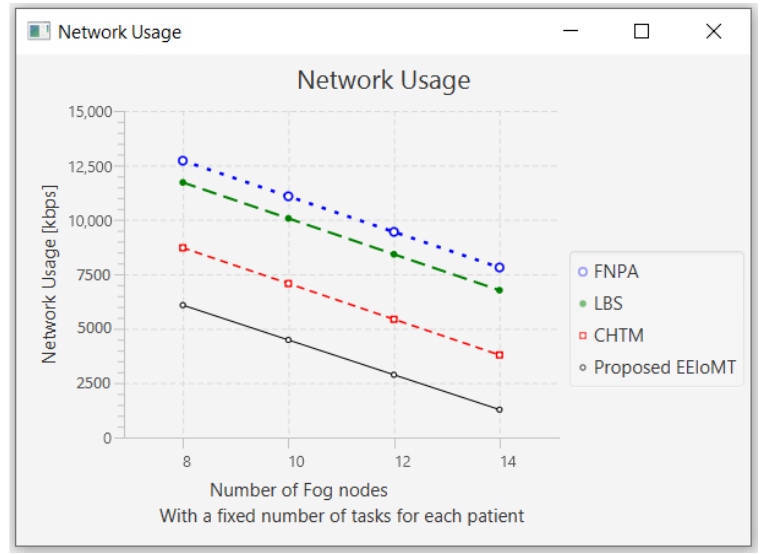
Figure 14. Network usage comparison when changing the number of fog nodes.